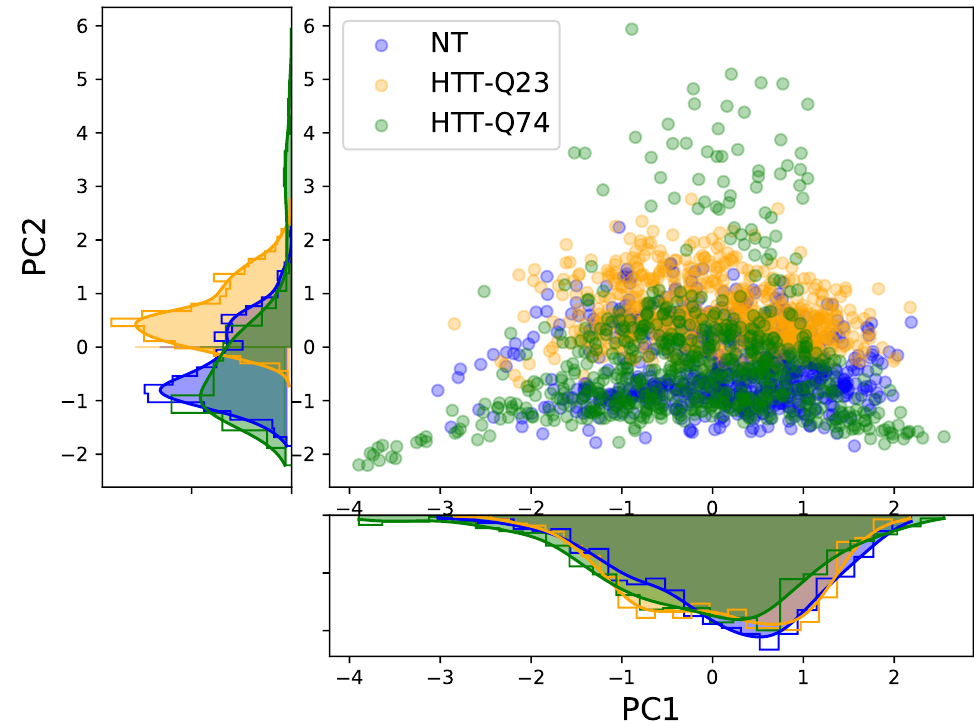
Figure 5. Scores of the two main PCs. Their respective distributions are also represented. Figure 6 shows a scatter plot of the scores of LD1 and LD2 for each spectrum in the training set. The centroids of the distributions are indicated with a square, and the error bars represent the standard deviation of the distributions. It can be observed that LD1 and LD2 clearly discriminated among the three cellular groups. The first discriminant function mainly separated HTT-Q74 from HTT-Q23 and NT, while the second discriminated between HTT-Q23 and NT. Concretely, the HTT-Q74 cell samples were located on the negative part of LD1, the HTT-Q23 cell samples were located on the positive part of LD1 and the positive part of LD2, and the NT samples were located on the positive part of LD1 and the negative part of LD2. In addition, Table 1 shows the centroids of the groups (the mean values of both functions for the spectra of the same cell